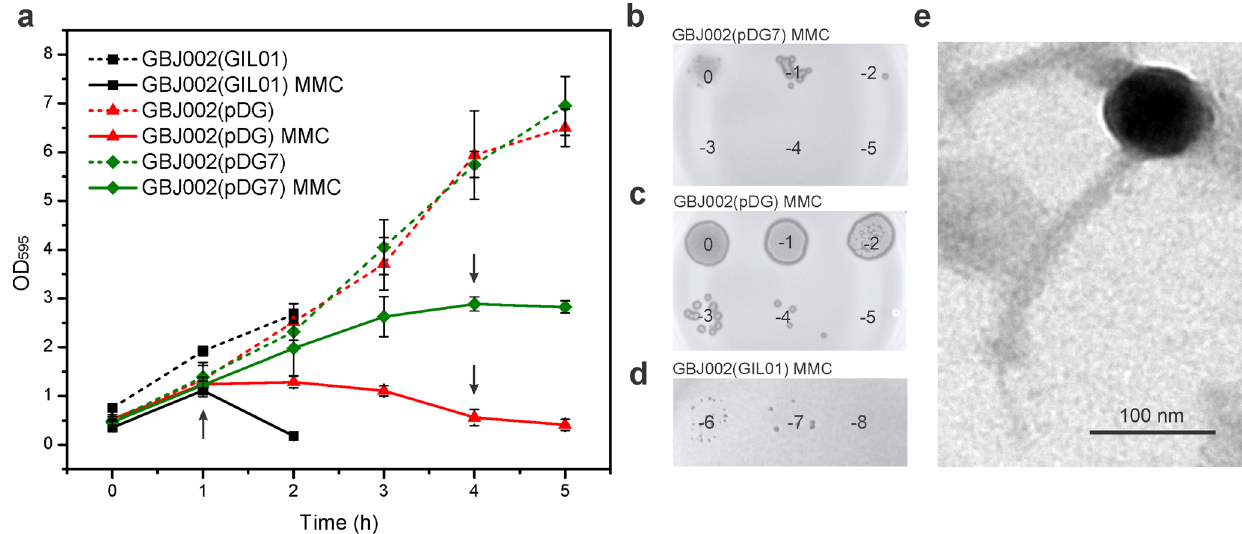
Fig. 3 Gp7 represses the induction of the lytic cycle of jumbo phage pBtic235. a Comparison of growth kinetics of B. thuringiensis strains GBJ002(GIL01) (black), GBJ002(pDG) (red), and GBJ002(pDG7) (green). IPTG (0.1 mM) was added to GBJ002(pDG) and GBJ002(pDG7) cultures after dilution of the overnight culture in fresh LB medium. MMC (100 ng mL − 1 ) was added to half of the cultures in the early exponential phase (OD 595 , 0.3 – 0.4) at time zero. Bacterial density of the MMC-treated cultures is shown with solid lines, and that of the untreated cultures is shown with dotted lines. Bacterial growth was measured for 5 h in 1-h intervals or until complete cell lysis of MMC-treated GBJ002(pDG) culture. Black arrows indicate the times at which the culture samples were collected for determination of phage counts in b – d . Each data point represents the mean of three replicates. Error bars indicate standard deviations. Spot titers of MMC-treated culture supernatants of strains GBJ002(pDG7) b , GBJ002(pDG) c and GBJ002(GIL01) d on the recipient host, B. thuringiensis HER1410. The experiment was performed in duplicate. e Representative transmission electron micrograph of the pBtic235 phage showing an isometric head of ~80-nm diameter and an ~200-nm-long tail. Scale bar, 100